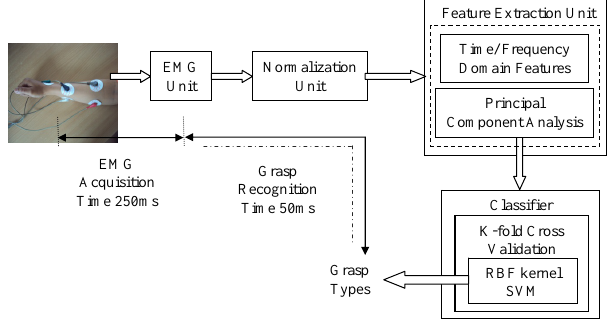
Figure 4. Grasp Recognition Architecture in the SHC